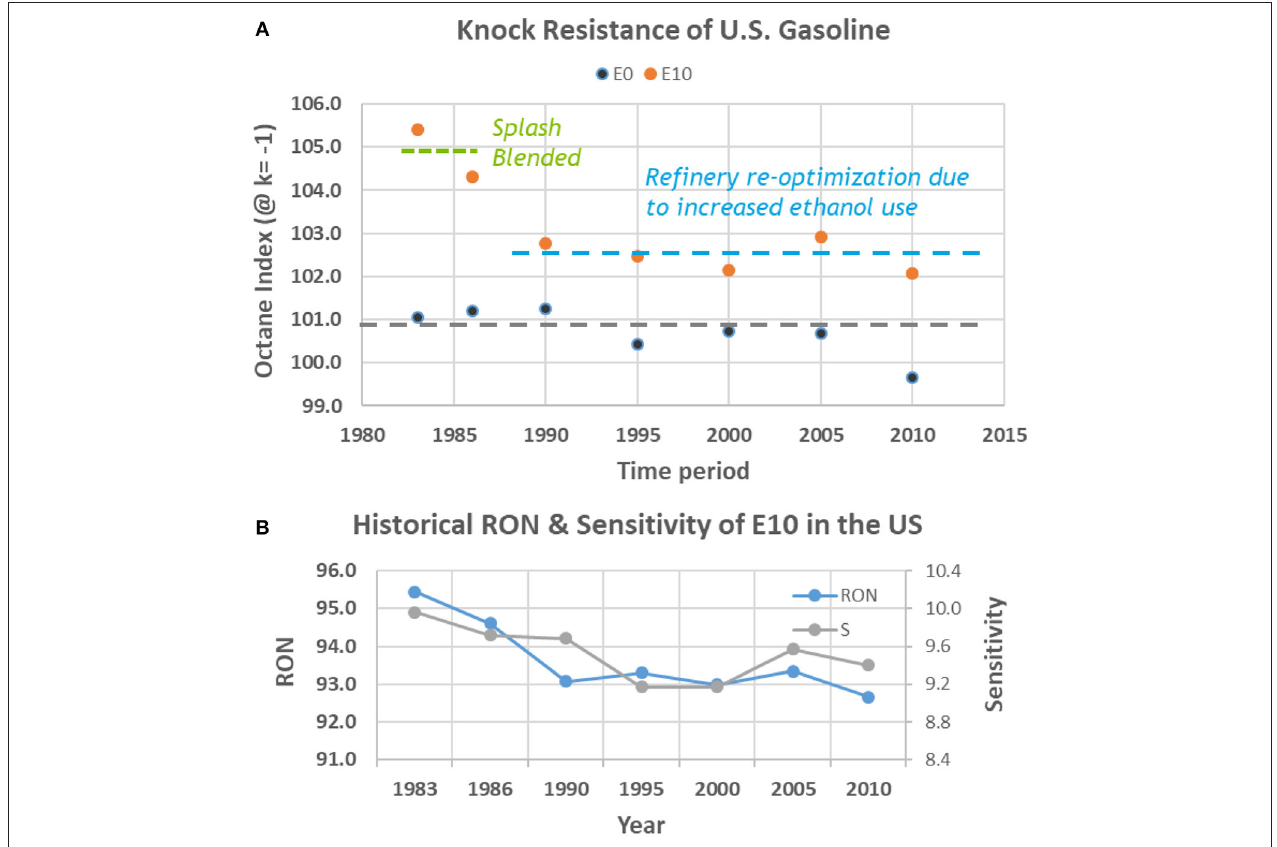
FIGURE 8 | Historical octane data in the U.S. showing (A) evolution in octane index, and (B) changes in RON and sensitivity over time. Refinery re-optimization became more widespread post 1990 ( Anderson et al.,